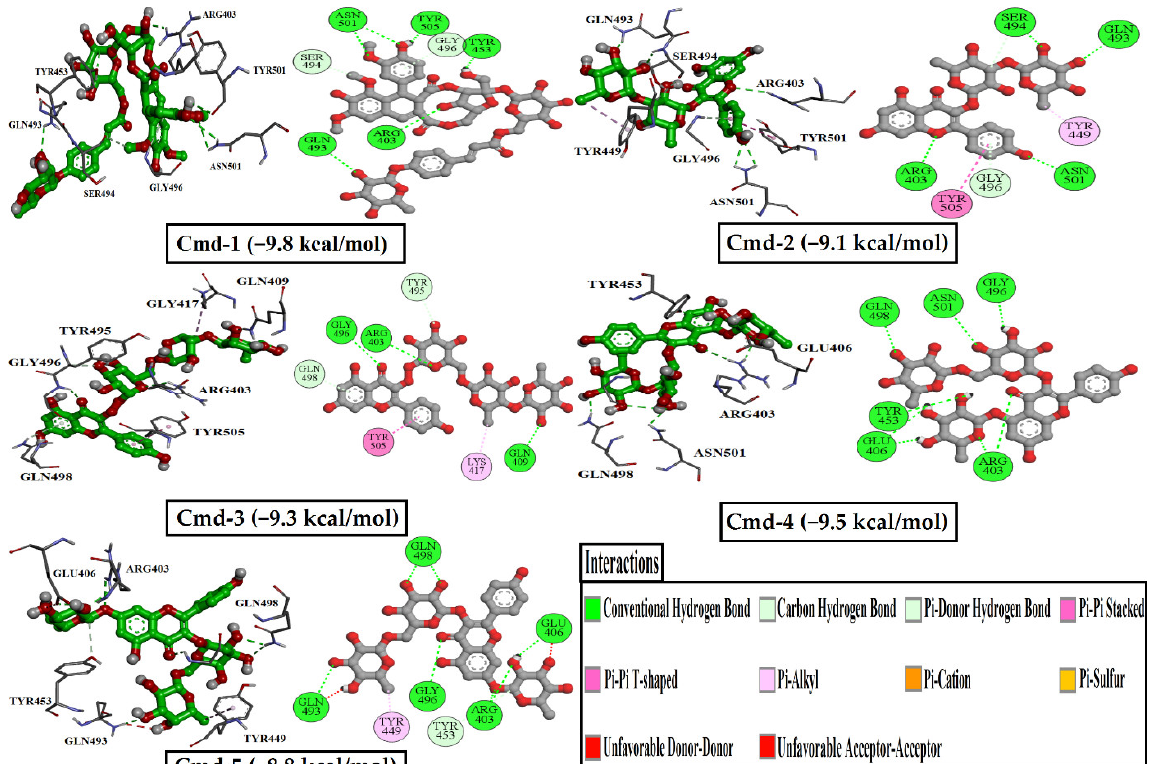
Figure 2. Depiction of binding modes and docking score for the best-investigated phytochemical Cmds with the wild-type RBD of SARS-CoV-2.